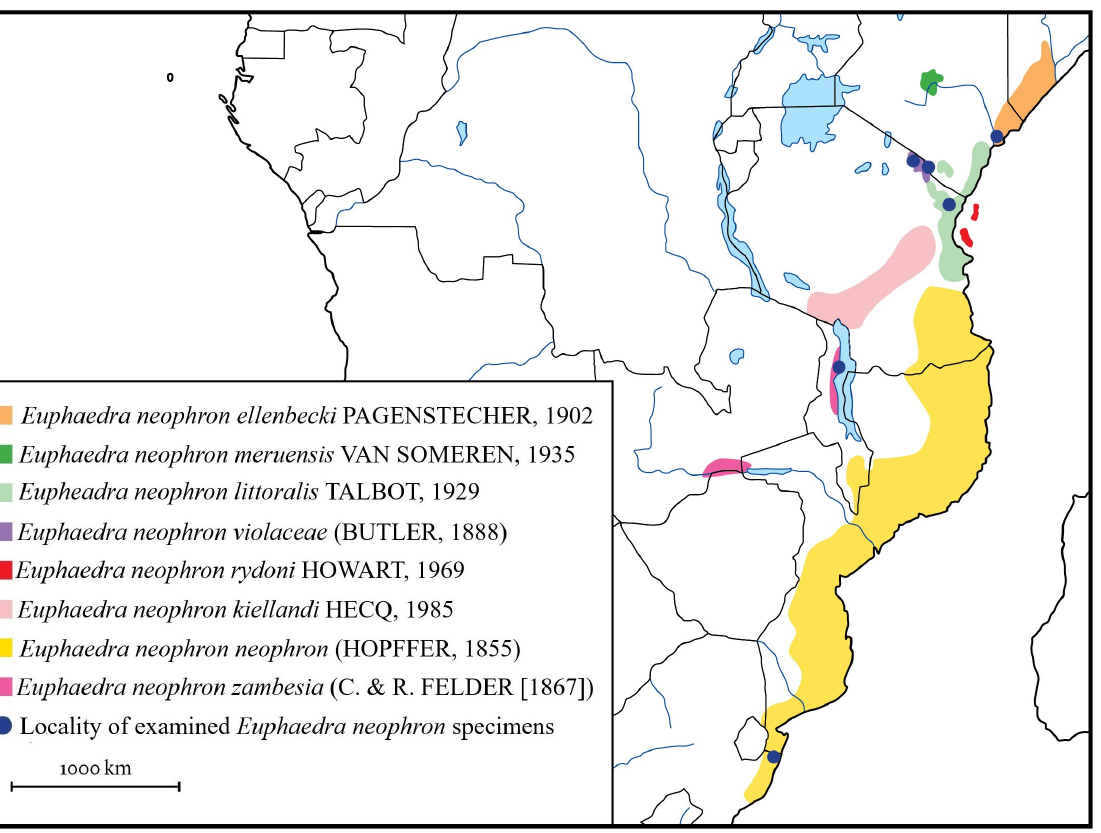
Figure 1. The main morphs of Euphaedra neophron subspecies from violet to green. The dominant colour is indicated as violet (V), blue (B), and green (G): A = E. n. violaceae (V); B = E. n. ellenbecki (V);